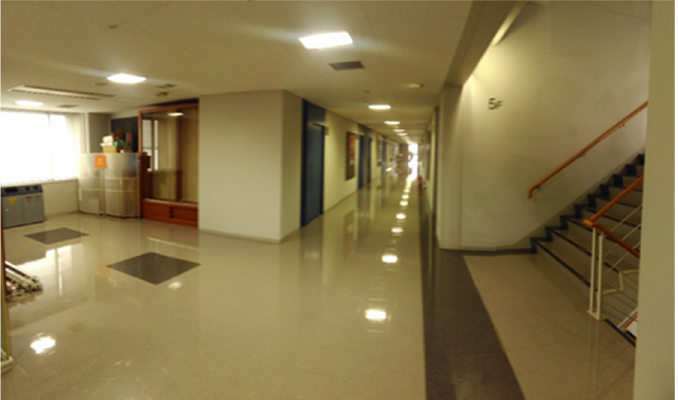
Figure 4. The experiment environment.